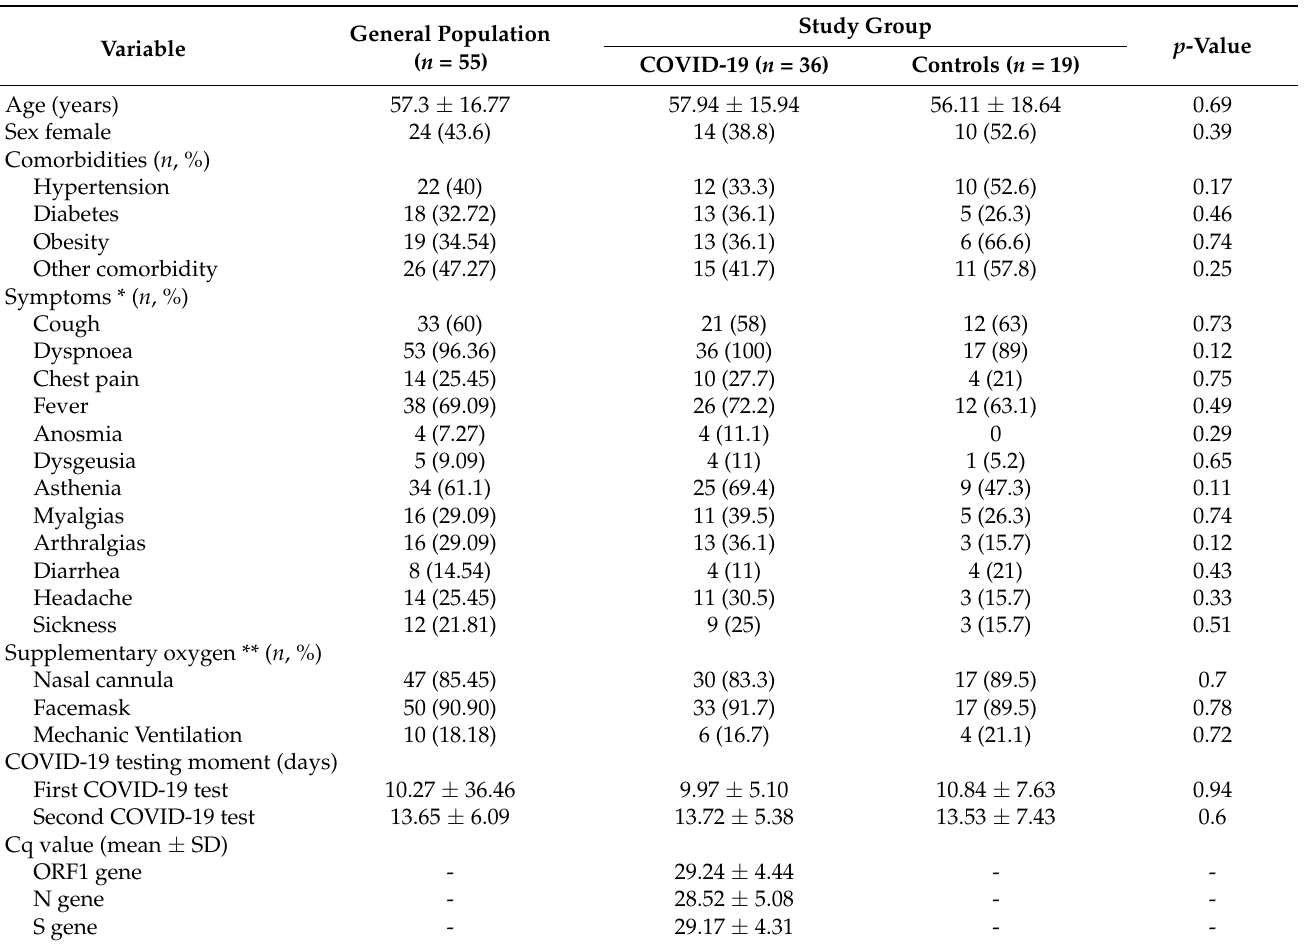
Table 1. General data of the study population classified into the COVID-19 and control groups according to the second SARS-CoV-2